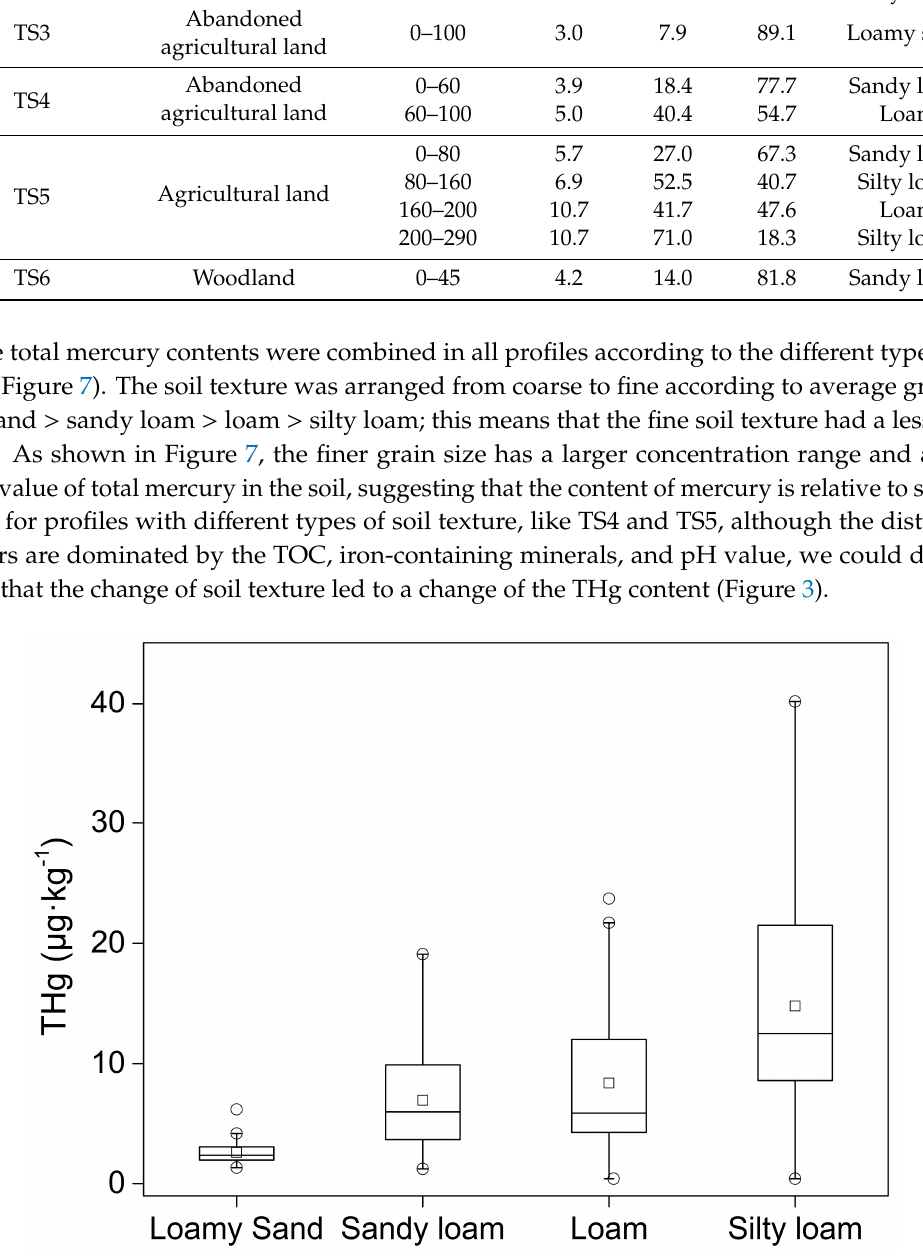
Figure 7. The THg content in different types of soil texture (o represents outliers, and □ represents mean values).